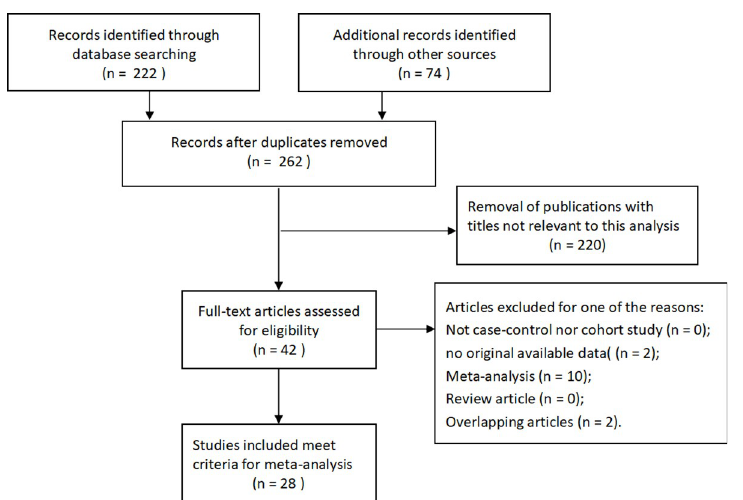
Fig 1. The flowchart of literature search and selection